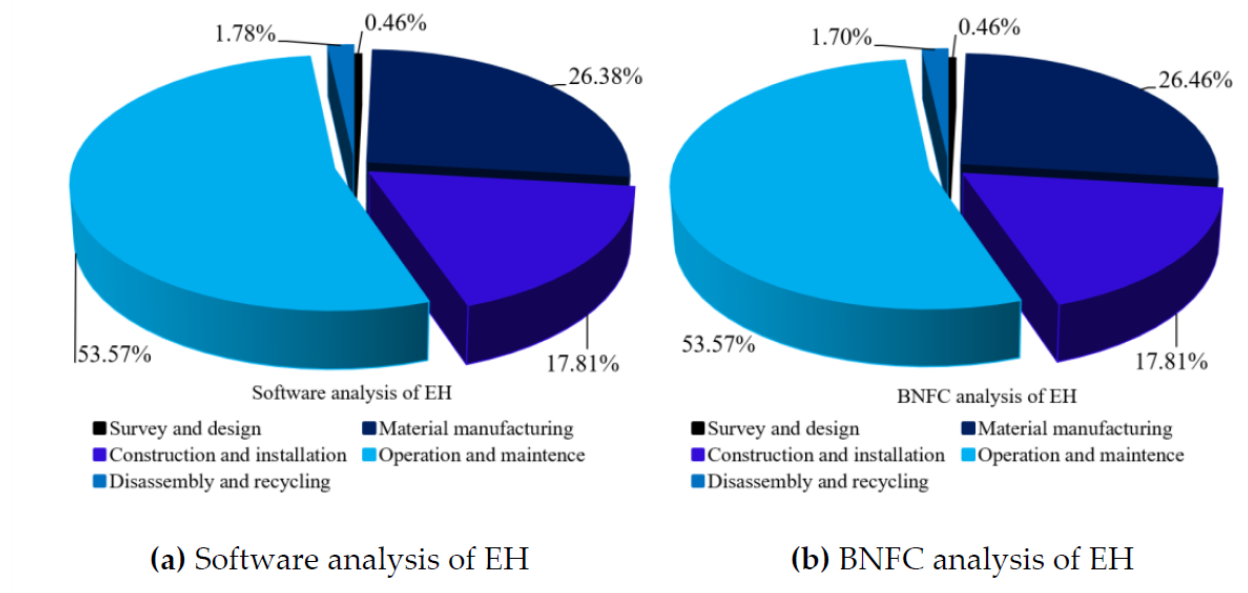
Figure 8. Comparison diagram of research and analysis conclusions of EH environmental impact